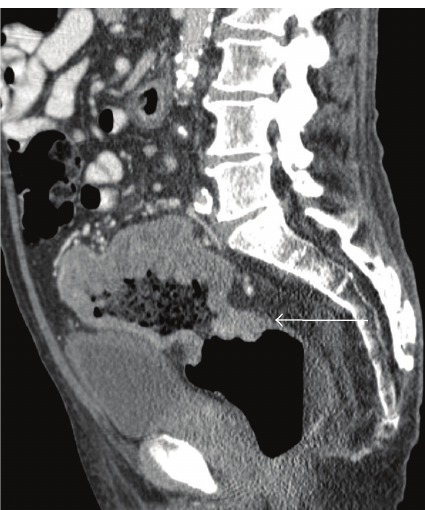
Figure 5: Large upper rectal adenocarcinomawith possible involve- ment of the bladder wall there is a large aneurysm-type carcinoma (arrow) of the rectum present with stranding of the fat between the tumor and the bladder which is concerning for bladder involvement which would classify the tumor as